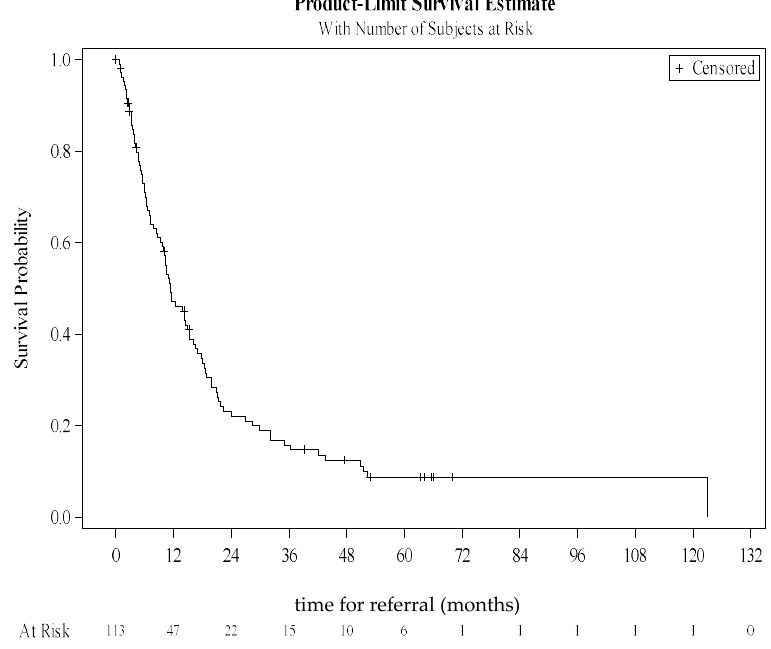
Figure 3. Kaplan-Meier curve estimating time to referral to primary care.